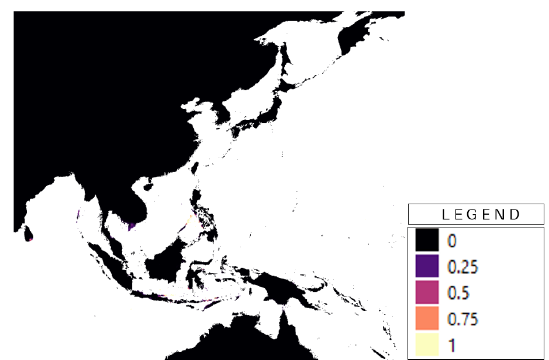
Figure 4. Visualized prediction within the Philippines’